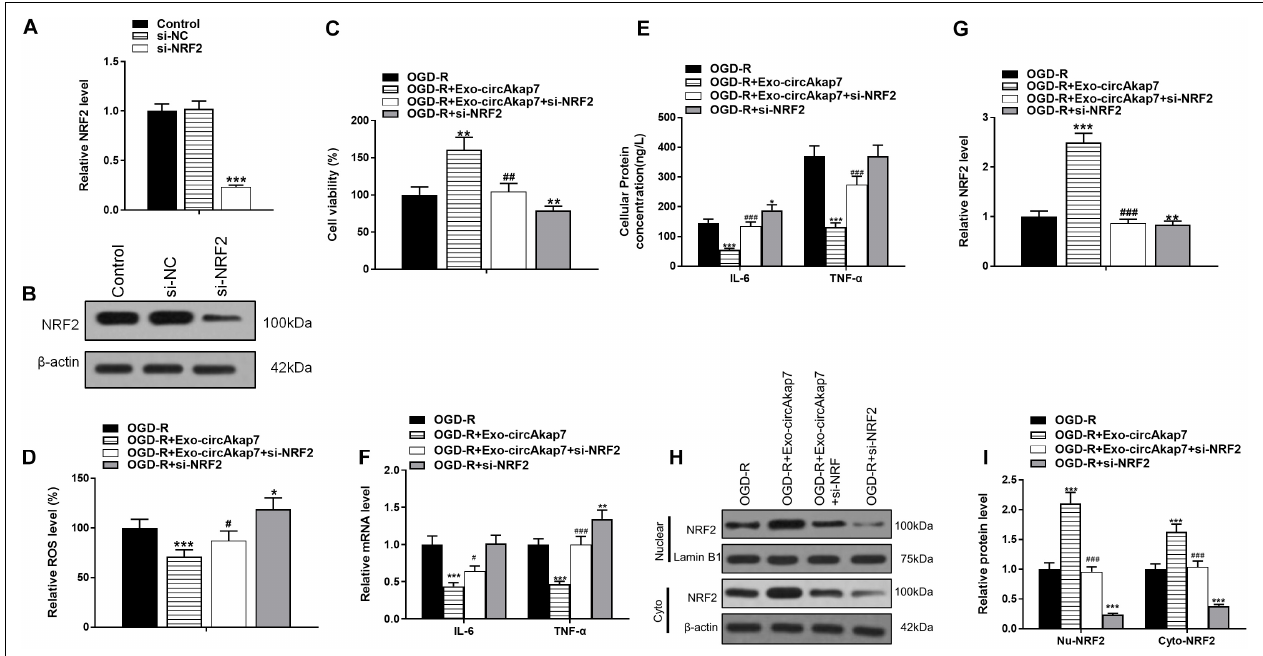
FIGURE 10 | Co-culture with exo-circAkap7 attenuates OGD-R-induced cellular injury by promoting NRF2-mediated oxidative stress and inflammatory responses. (A,B) RT-PCR and western blot results showing the levels of NRF2 in astrocytes. Each experiment was repeated three times. (C) Cell viability as assessed by an MTT assay. (D) Detection of cellular ROS levels. (E) ELISA results showing the expression of IL-6 and TNF- α in astrocytes. (F) RT-PCR results showing the levels of IL-6 and TNF- α in astrocytes. (G) RT-PCR results showing the levels of NRF2 in astrocytes. (H,I) The expression of cytosolic and nuclear NRF2 as analyzed by western blotting and quantified. Data are expressed as the mean ± SEM, each experiment was repeated six times. * p < 0.05, ** p < 0.01, *** p < 0.001 vs. OGD-R, # p < 0.05, ## p < 0.01, ### p < 0.001 vs.